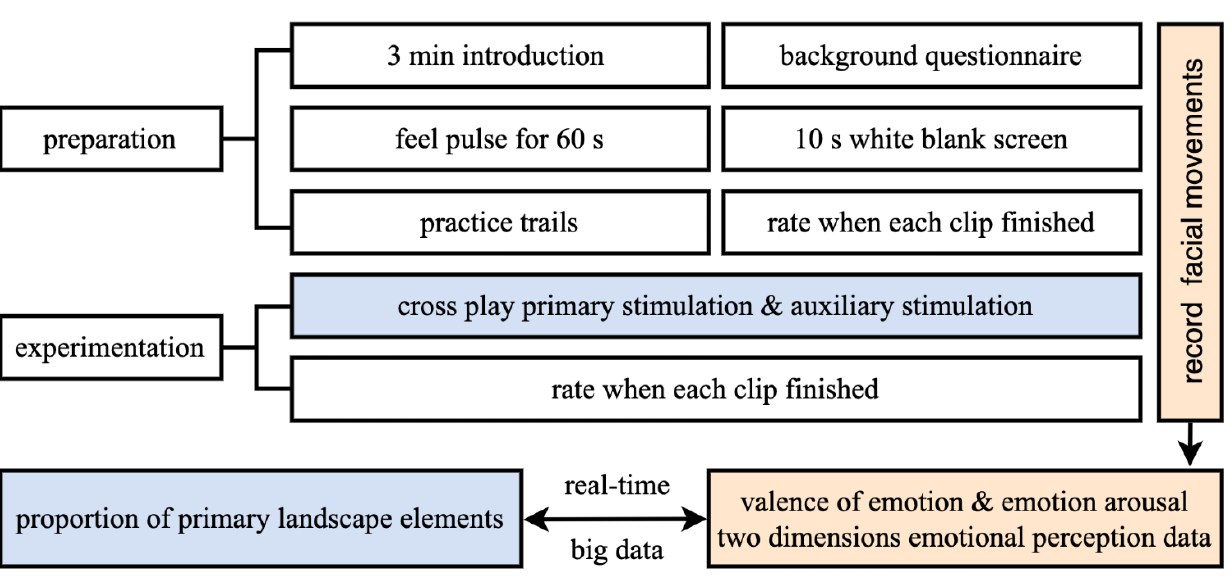
Figure 5. Procedure of preparation and experimentation.